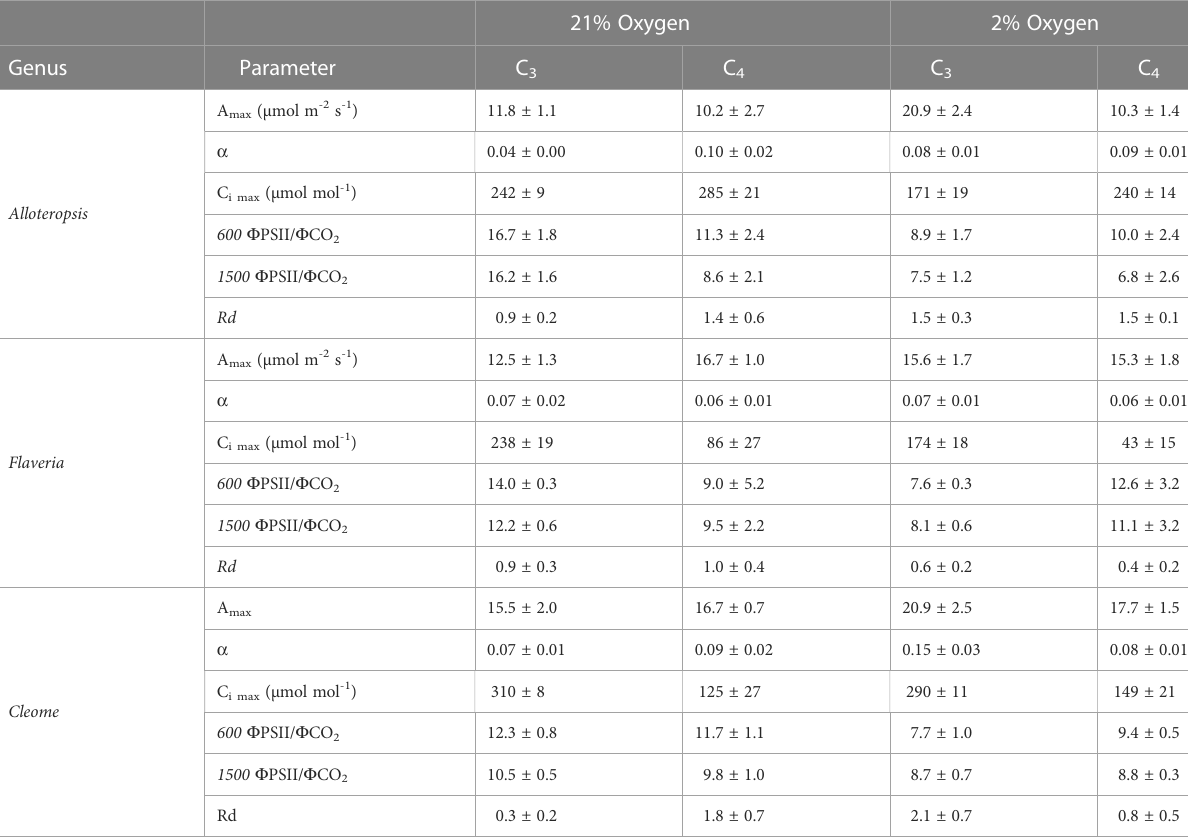
TABLE 1 Light response curve parameters estimated from steady state light response curves under 21% and 2% O 2 on phylogenetically linked C 3 and C 4 Alloteropsis , Flaveria and Cleome